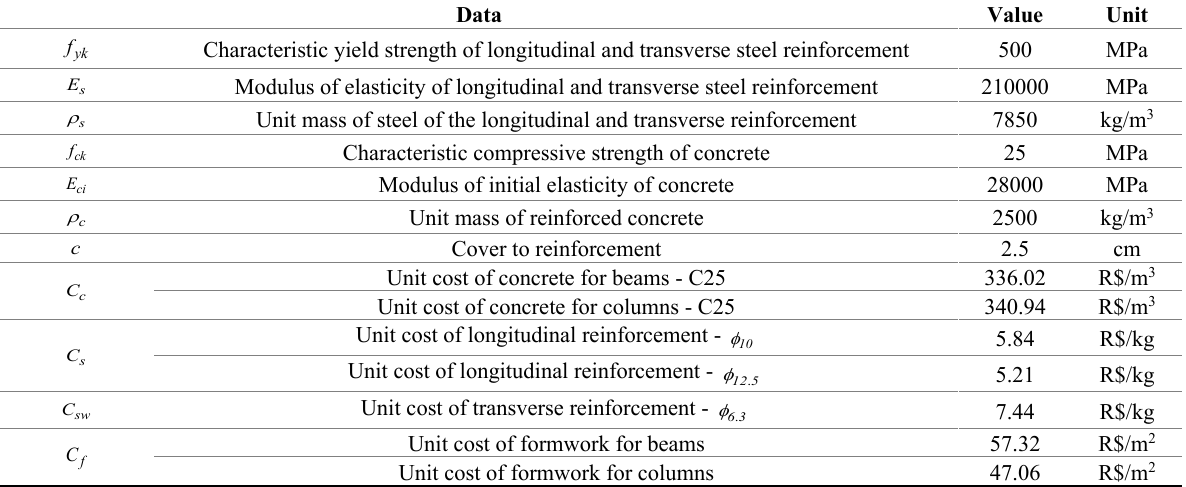
Table 1. Input data of examples I and II.